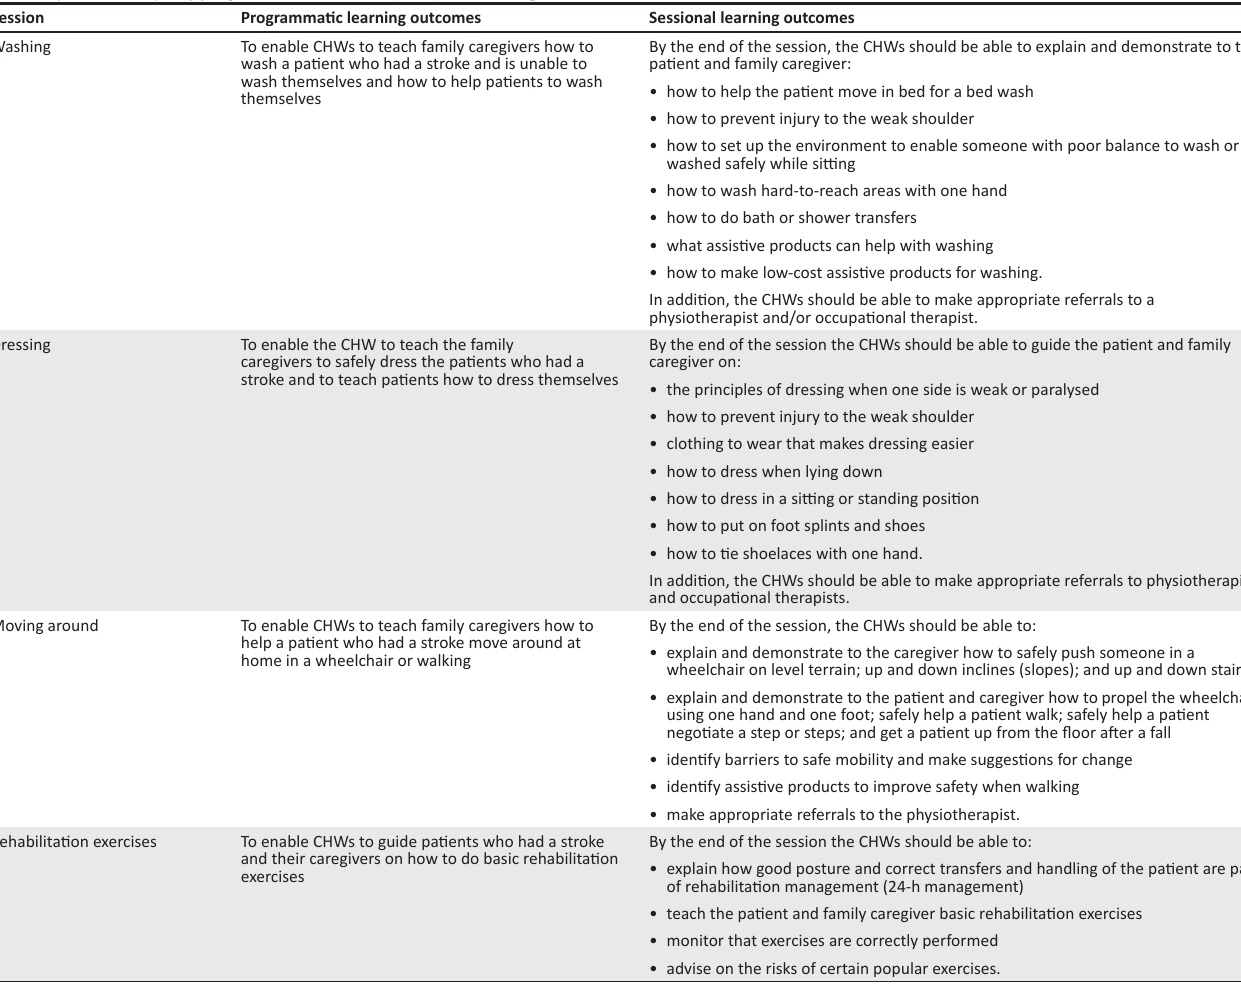
TABLE 5 (Continues...): Key programmatic outcomes (aims) and learning outcomes of the 16 sessions. Session Programmatic learning outcomes Sessional learning